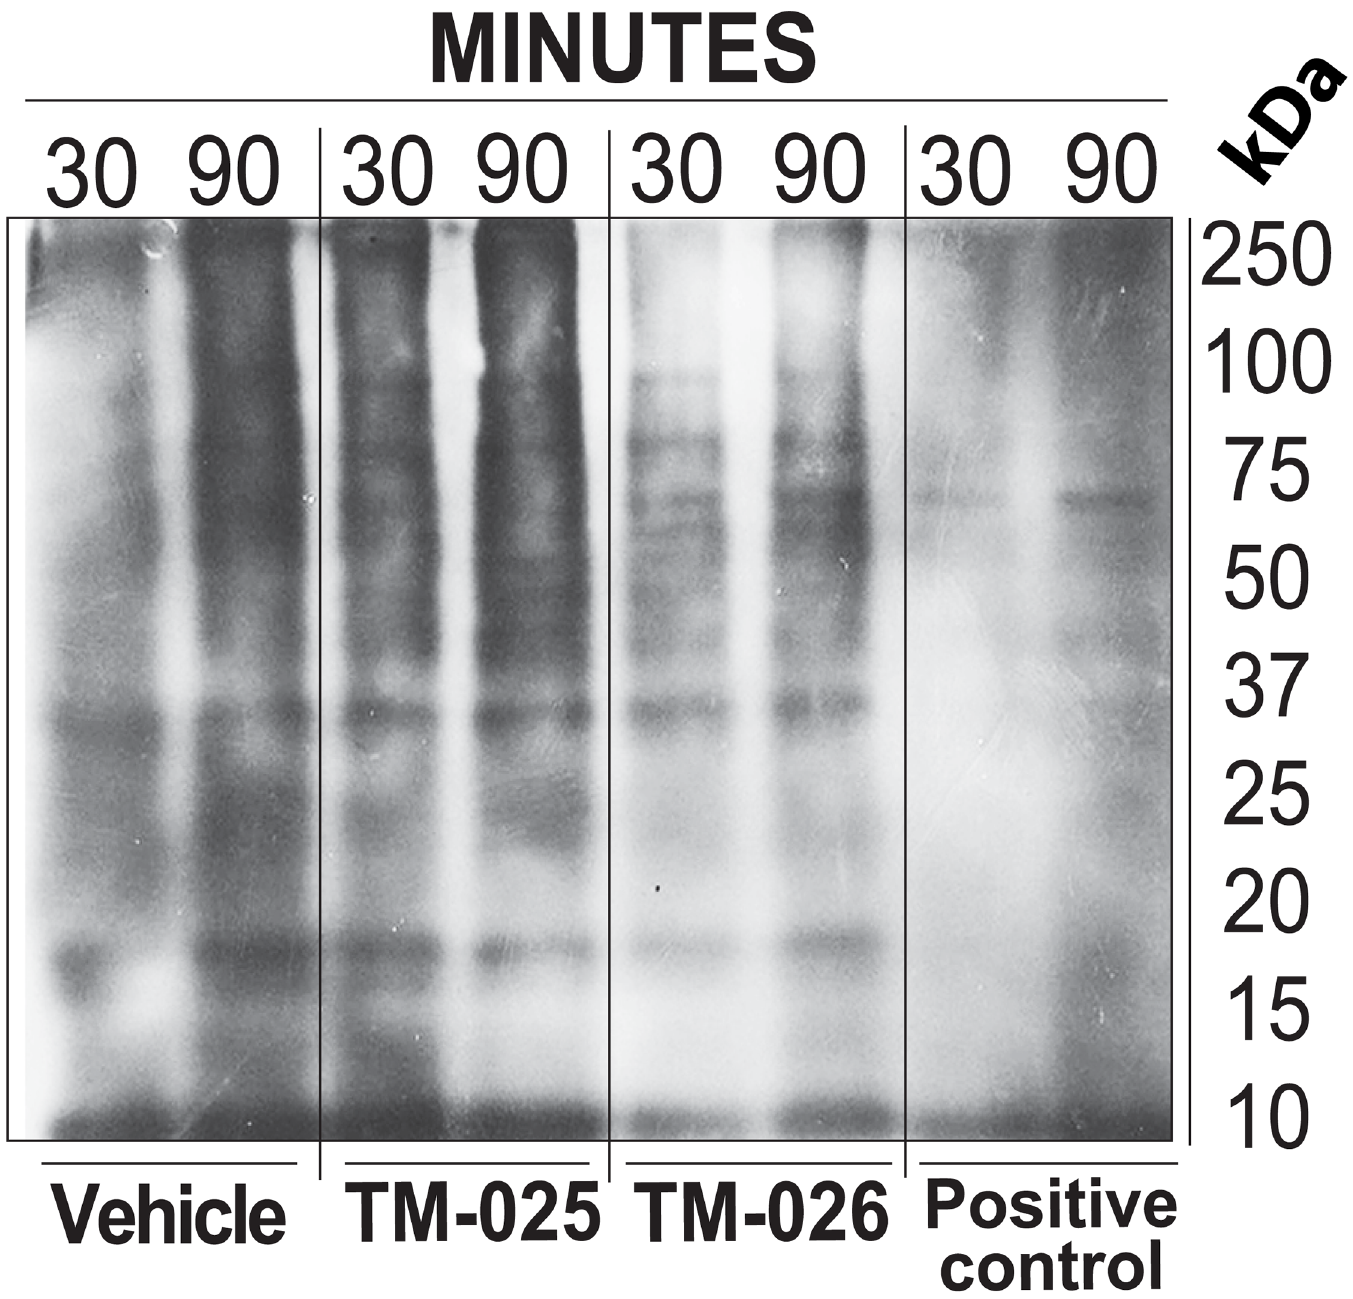
Fig 2. PCT analogs did not inhibit protein synthesis, which is a capstone property of PCT. Detection of protein synthesis was performed using the Click-iT azide-alkyne streptavidin HRP reaction model with Western blot. SSC104 cells were incubated in L-methionine-free medium containing 50 μ M Click- iT AHA and subsequently treated with 100 nM of TM-025, TM-026 and PCT for 30 min and 90 min. Immunoblot shows the newly synthesized proteins (bands) in TM-025 and TM-026-treated cells, and a lack of such synthesis in PCT-treated